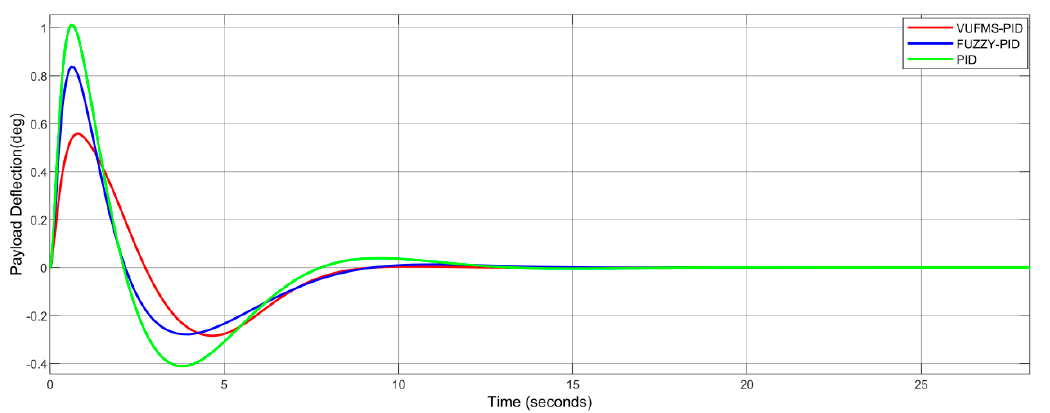
Figure 11. Payload’s swing angle ( θ ) using VUFMS-PID, FUZZY-PID and PID controller under working condition 2.